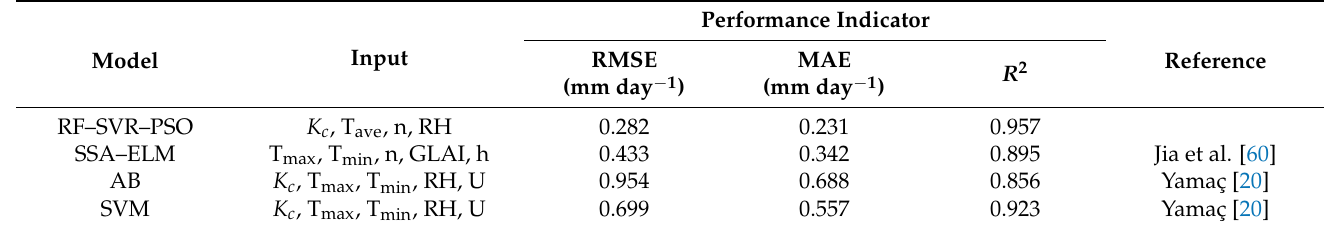
Table 4. Performance indices for ET c estimation using the hybrid model and different approaches.